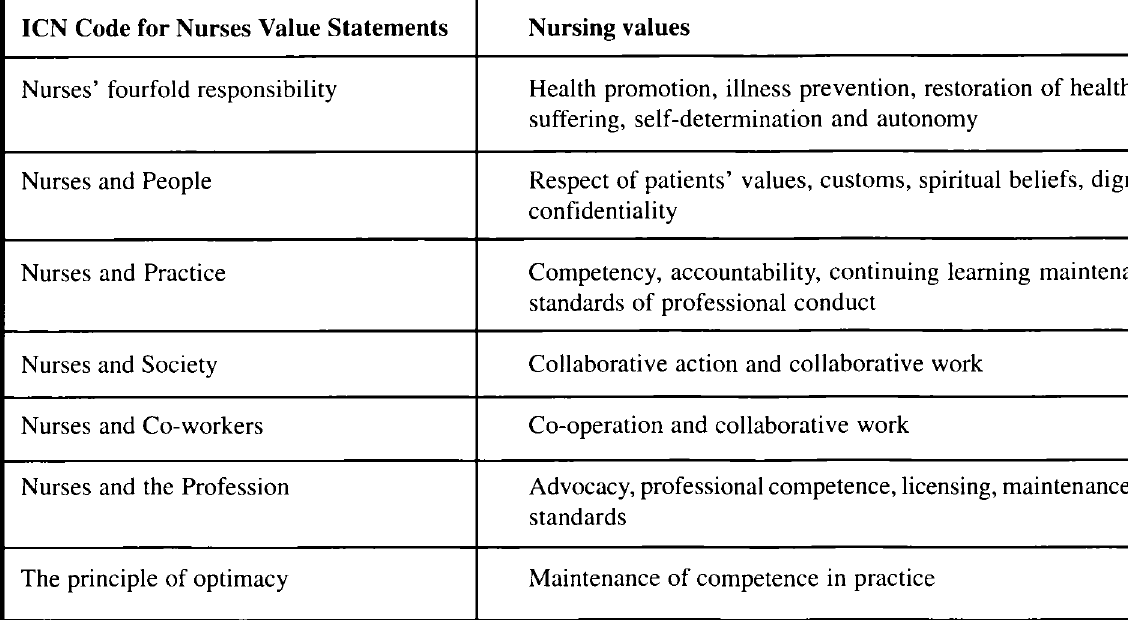
Table 1 : ICN Code for Nurses value statements and nursing values ICN Code for Nurses Value